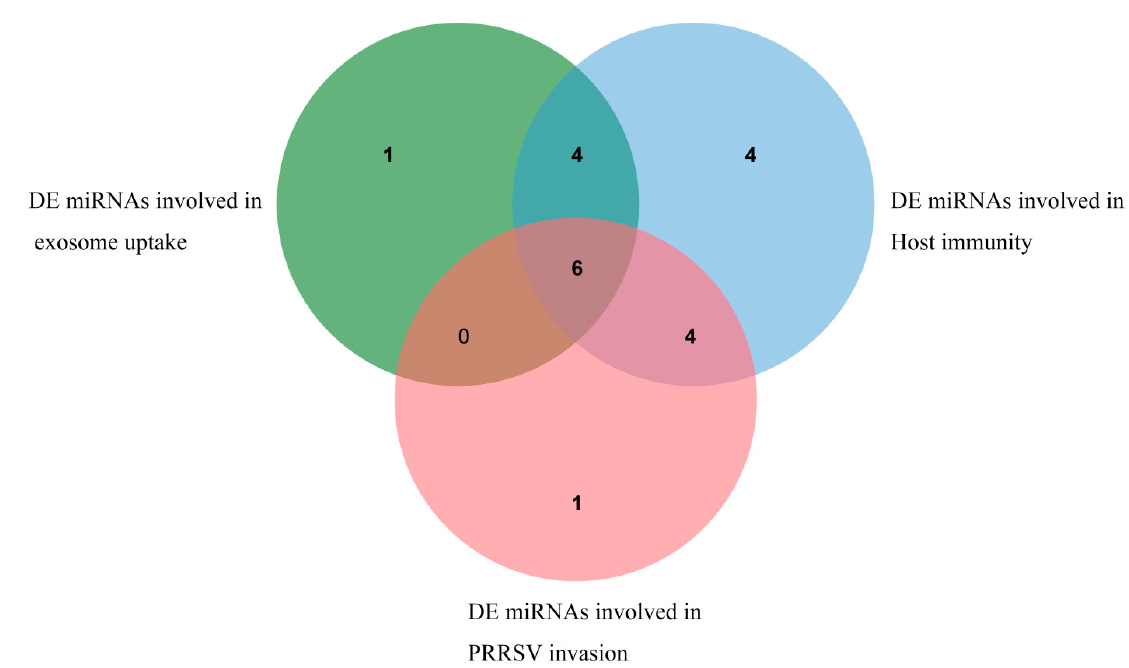
Figure 7. DE miRNAs related to exosome uptake, PRRSV invasion, and immunity.